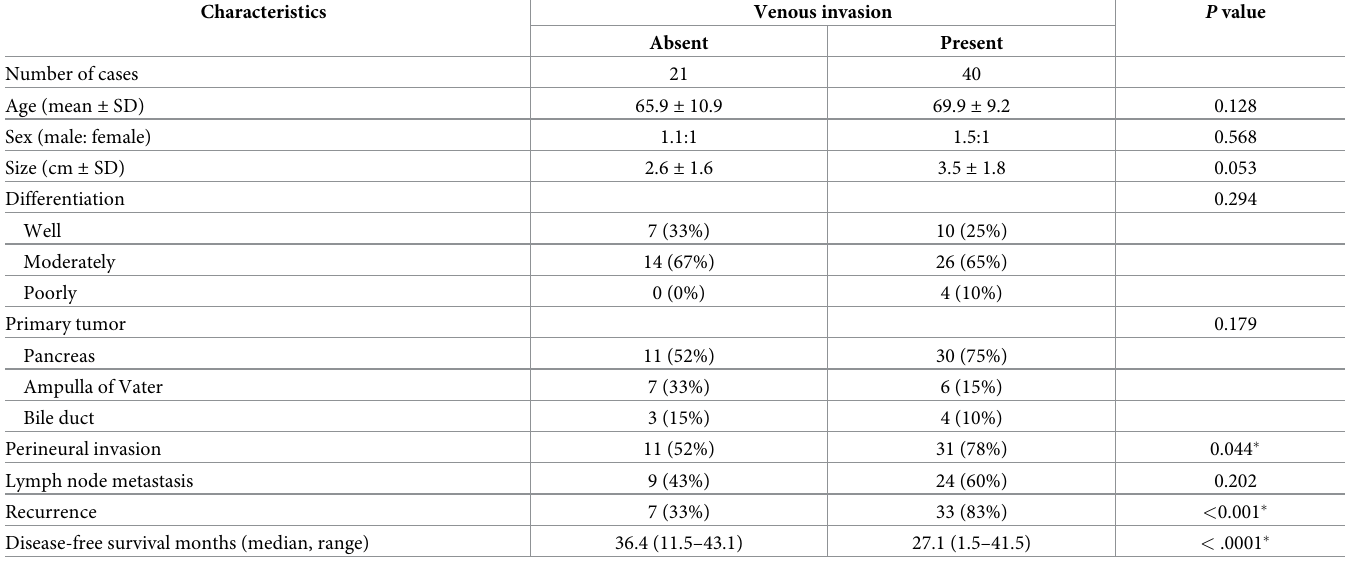
Table 5. Association between VI and other clinicopathologic features in pancreatobiliary tract cancers.